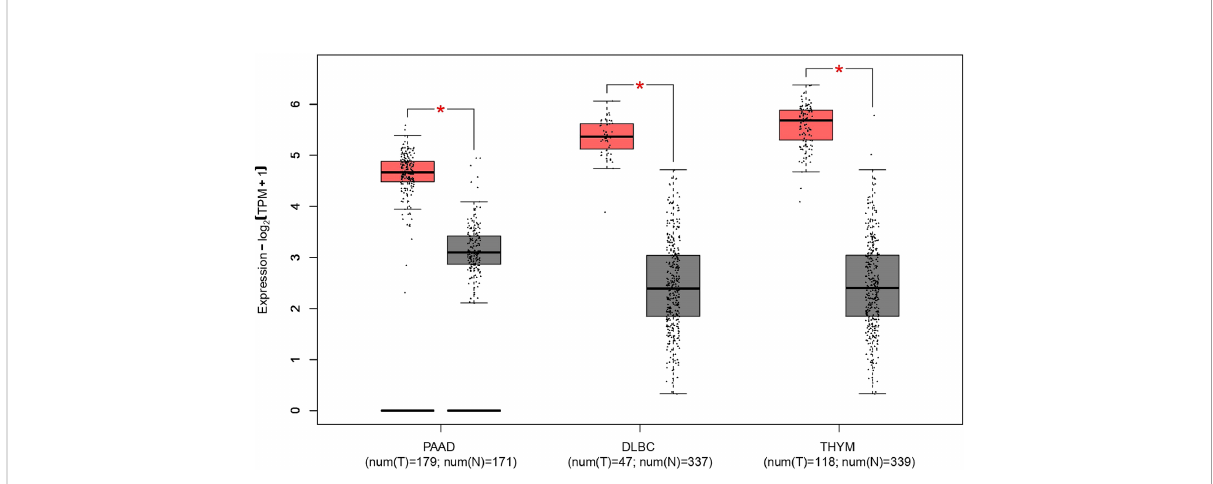
FIGURE 3 Differences in ribonuclease P protein subunit p30 ( RPP30 ) expression between DLBC, PAAD, THYM, and normal tissues. *Signi fi cant difference between tumor and normal tissues; DLBC, Diffuse large B-cell lymphoma; PAAD, Pancreatic adenocarcinoma; THYM, Thymoma. Red represents tumor group, gray represents normal